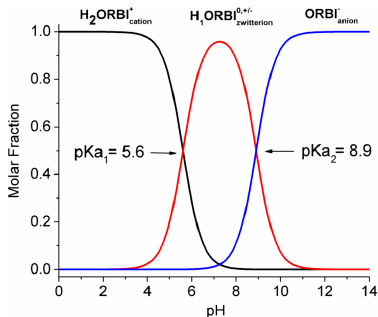
Figure 10. pH-dependent acid-basic ORBI species distribution. The molar fraction ( α ) of each species was calculated as follows: (cid:2009) (cid:2870) (cid:3404) (cid:4670)(cid:1834) (cid:2870) (cid:1841)(cid:1844)(cid:1828)(cid:1835) ((cid:3030)(cid:3028)(cid:3047)(cid:3036)(cid:3042)(cid:3041))(cid:2878) (cid:4671)/(cid:1829) (cid:3404) (1 (cid:3397) ((cid:1837)(cid:1853) (cid:2869) /(cid:4670)(cid:1834) (cid:2878) (cid:4671)) (cid:3397) ((cid:1837)(cid:1853) (cid:2869) (cid:3400) (cid:1837)(cid:1853) (cid:2870) /(cid:4670)(cid:1834) (cid:2878) (cid:4671) (cid:2870) )) (cid:2879)(cid:2869) ; (cid:2009) (cid:2869) (cid:3404) (cid:4670)(cid:1834) (cid:2869) (cid:1841)(cid:1844)(cid:1828)(cid:1835) ((cid:3053)(cid:3050)(cid:3036)(cid:3047)(cid:3047)(cid:3032)(cid:3045)(cid:3036)(cid:3042)(cid:3041))(cid:2868),(cid:2878)/(cid:2879) (cid:4671)/(cid:1829) (cid:3404) (cid:2009) (cid:2870) ((cid:1837)(cid:1853) (cid:2869) /(cid:4670)(cid:1834) (cid:2878) (cid:4671)) ; (cid:2009) (cid:2868) (cid:3404) (cid:3427)(cid:1841)(cid:1844)(cid:1828)(cid:1835) ((cid:3028)(cid:3041)(cid:3036)(cid:3042)(cid:3041))(cid:2879) (cid:3431)/(cid:1829) (cid:3404) (cid:2009) (cid:2870) ((cid:1837)(cid:1853) (cid:2869) (cid:3400) (cid:1837)(cid:1853) (cid:2869) /(cid:4670)(cid:1834) (cid:2878) (cid:4671) (cid:2870) ) ; where (cid:2009) (cid:2868) (cid:3397) (cid:2009) (cid:2869) (cid:3397) (cid:2009) (cid:2870) (cid:3404) 1 and (cid:1829) (cid:3404) (cid:3427)(cid:1834) (cid:2870) (cid:1841)(cid:1844)(cid:1828)(cid:1835) ((cid:3030)(cid:3028)(cid:3047)(cid:3036)(cid:3042)(cid:3041))(cid:2878) (cid:3431) (cid:3397) (cid:4670)(cid:1834) (cid:2869) (cid:1841)(cid:1844)(cid:1828)(cid:1835) ((cid:3053)(cid:3050)(cid:3036)(cid:3047)(cid:3047)(cid:3032)(cid:3045)(cid:3036)(cid:3042)(cid:3041))(cid:2868),(cid:2878)/(cid:2879) (cid:4671) (cid:3397) (cid:3427)(cid:1841)(cid:1844)(cid:1828)(cid:1835) ((cid:3028)(cid:3041)(cid:3036)(cid:3042)(cid:3041))(cid:2879) (cid:3431) . Curves show pH in steps of 0.1.